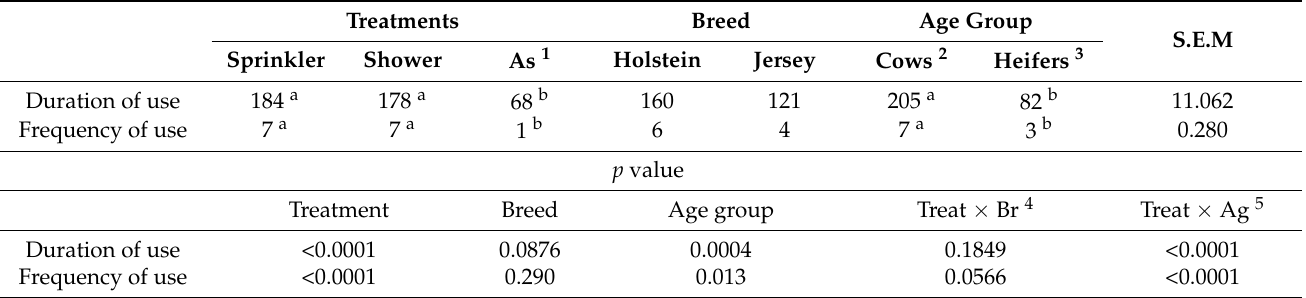
Table 3. Frequency and duration (minutes) of use of the systems heat-stress-reduction systems.